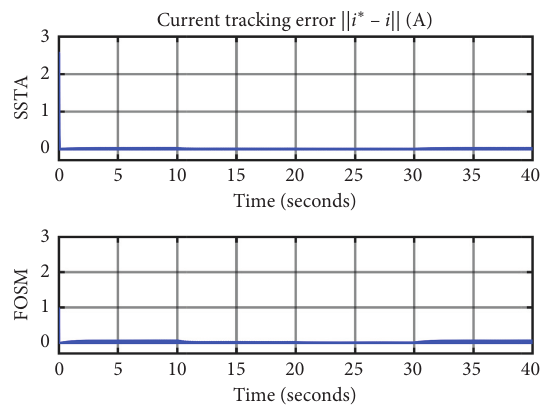
Figure 6: Tracking error for both controllers.